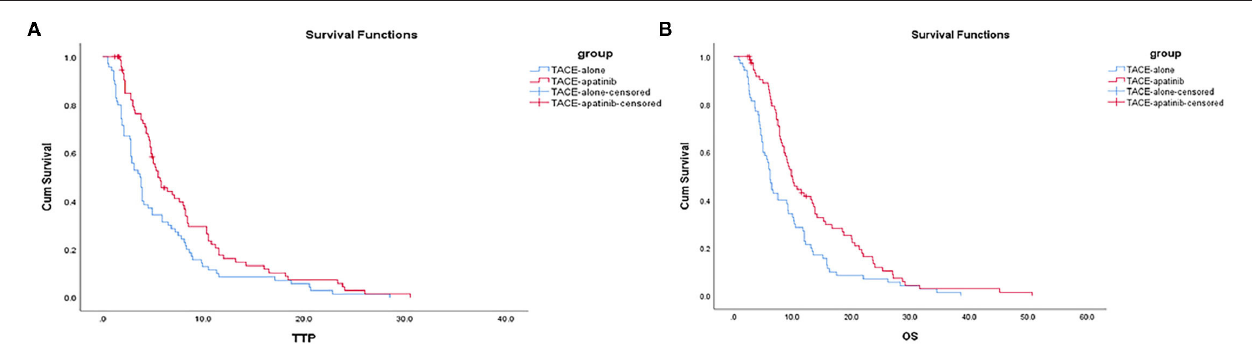
FIGURE 1 | (A) Time to progression curves in the two groups of patients. (B) Overall survival curves in the two groups of patients.